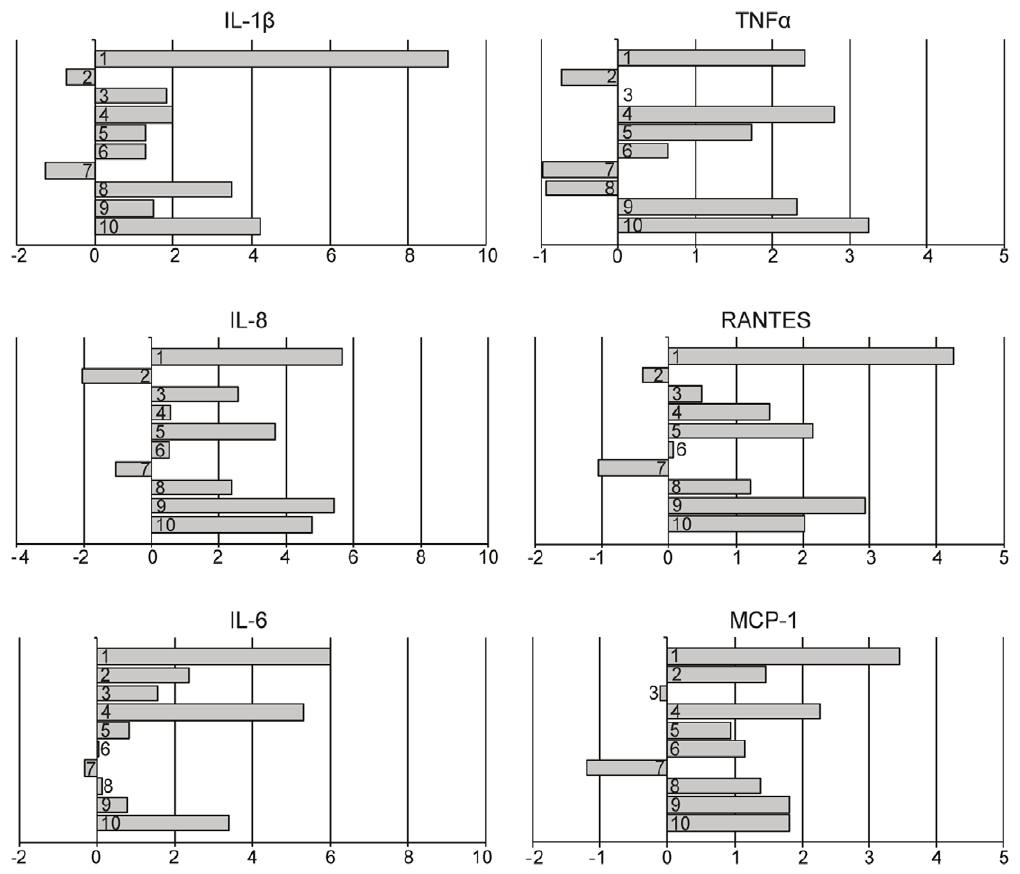
Figure 2. Expression of the inflammatory mediators in periodontitis-affected and healthy tissues obtained by RNA-seq. The bars show the expression (log 2 fold change) pattern based on RNA-Seq reads of IL-1 b , IL-6, IL-8, TNF a , RANTES and MCP-1.